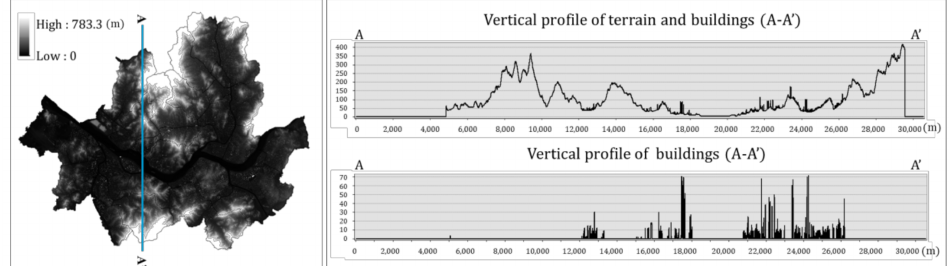
Figure 1. Topography map and vertical profile of Seoul. Data source: National Geographic Information Institute (NGII,